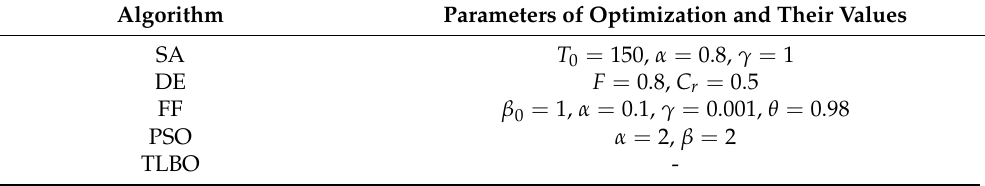
Table 2. Used optimization